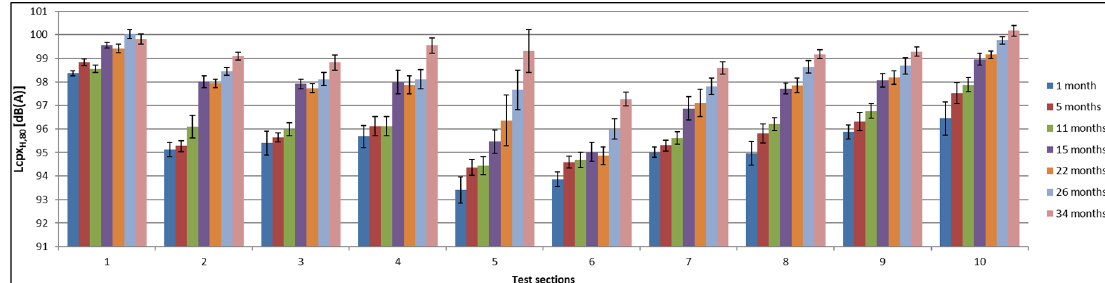
Figure 9. Overview of CPX measurements performed 1, 5, 11, 15, 22, 26 and 34 months after construction with the H1 tire at 80 km/h (with temperature correction).